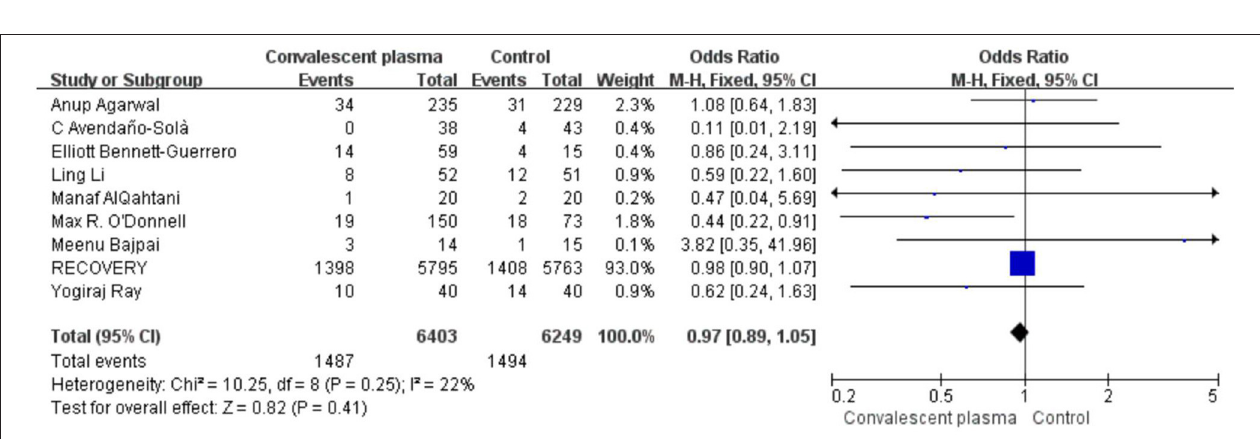
FIGURE 4 | Forest plot of pooled odds ratios (ORs) of mortality on 28-days ( n = 9 studies). Weights are from fixed-effects analysis. CI, confidence